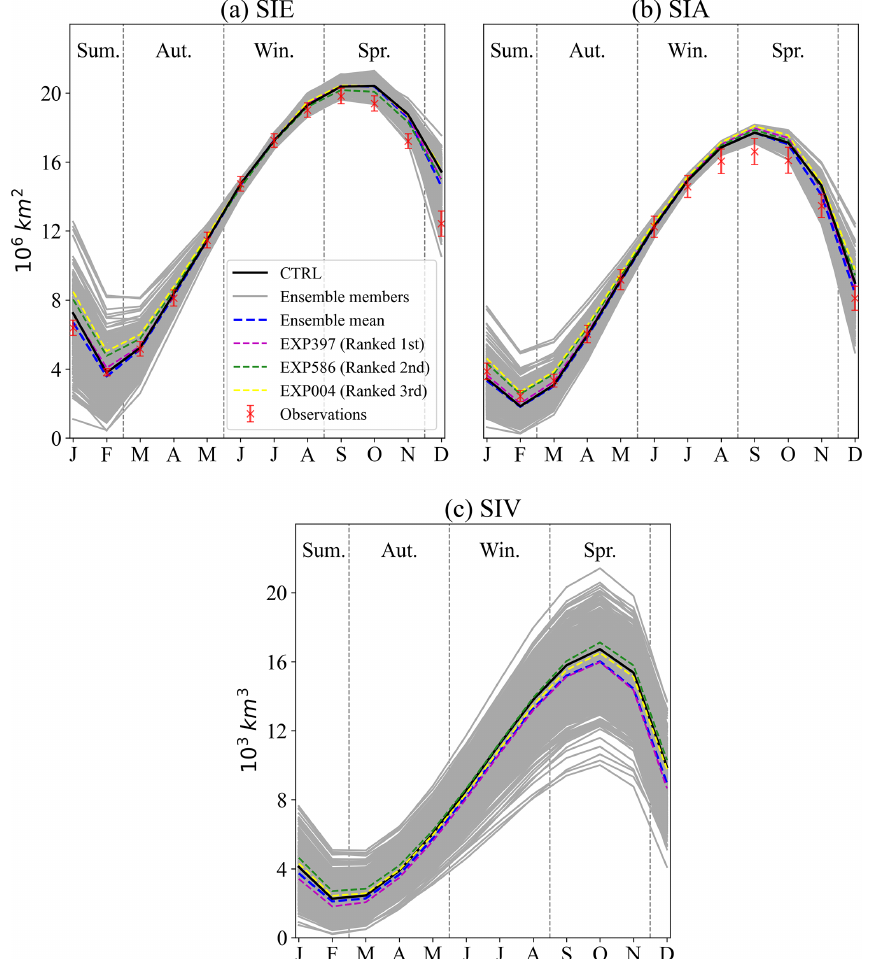
Figure 2. Simulated monthly climatologies of (a) sea ice extent (SIE), (b) area (SIA) and (c) volume (SIV) from 2008 to 2017; ensemble model means and results from four sets of experiments of interest are also highlighted. The SIE and SIA calculated from the CDR, AMSR-E and AMSR2, CERSAT, and OSISAF are used as references in the form of mean ± 1